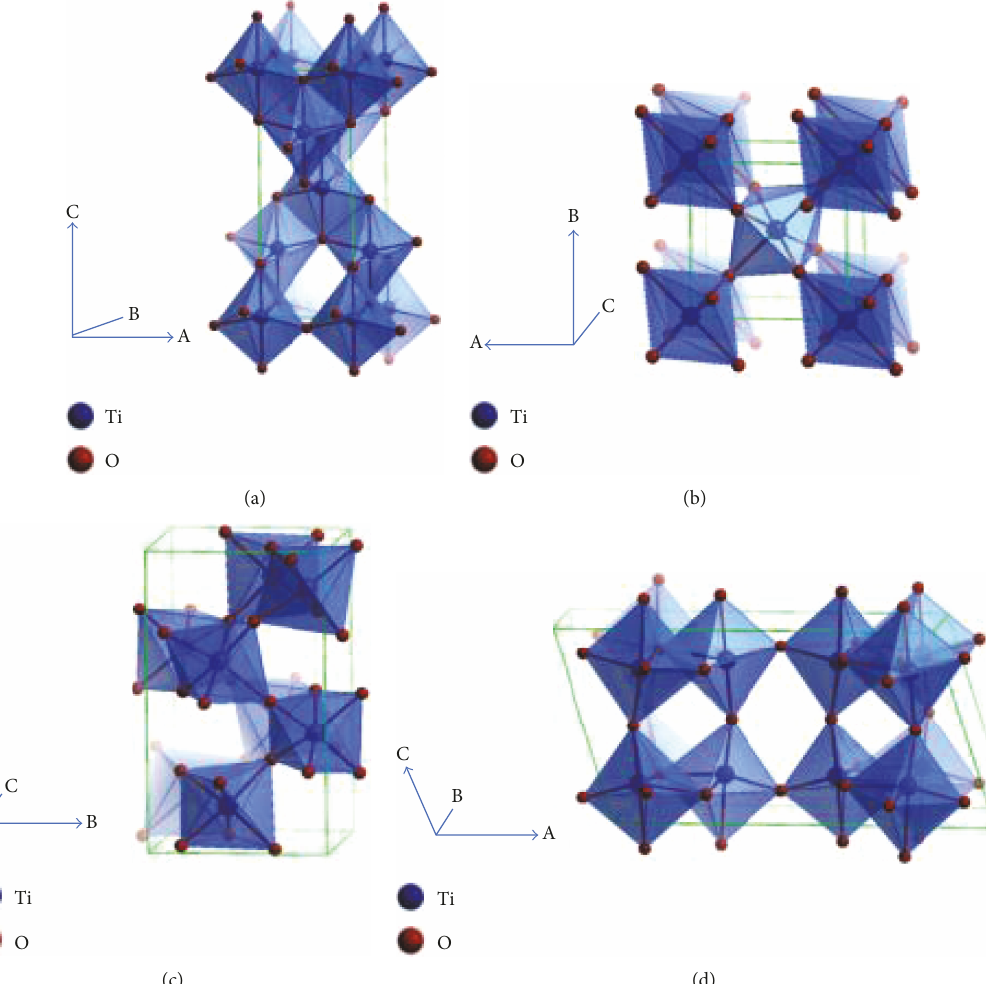
Figure 1: Crystalline structures of TiO from [25]. Copyright (2014) American Chemical